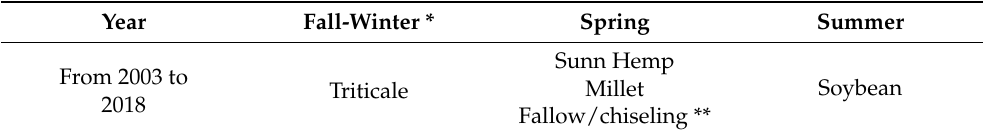
Table 3. Crop rotation has been used since 1997, highlighting management and species cultivated in each agricultural year’s fall–winter (April to July), spring (September to November), and summer (December to March) seasons.